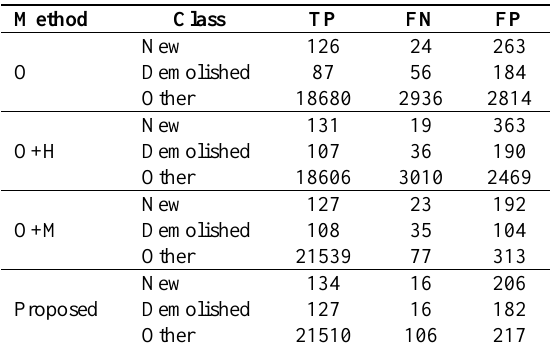
Table 4. Results for each method and building class The calculated values of Aprecision, Arecall, AF2-score, precision, recall, and F2-score for each building class (new, demolished, and other) according to Table 4 are plotted in Figure